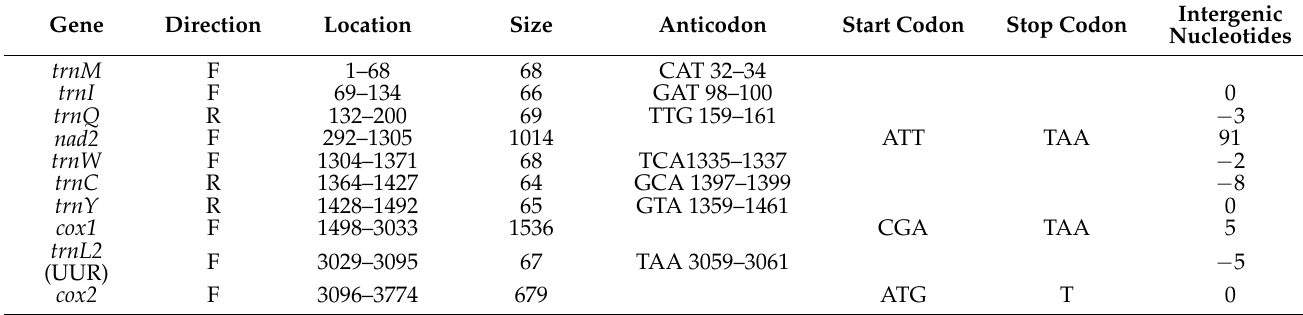
Figure 2. Linear map of the mitogenome of Hestinalis nama . The J-strand is located on the linear map, and the N-strand is under the linear map. Table 1. Annotation of Hestina persimilis